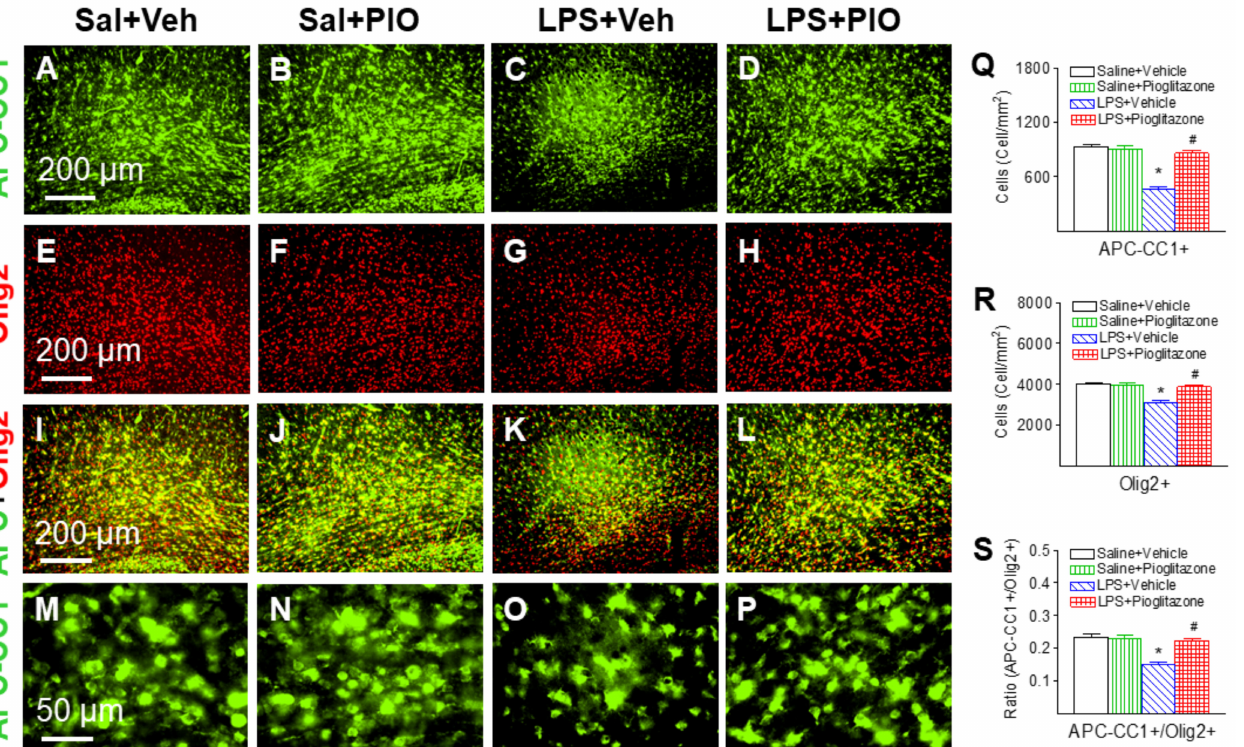
Figure 5. Pioglitazone attenuated neonatal LPS-induced reduction of mature oligodendrocyte cells (APC-CC1+, green) and total oligodendrocytes (Olig2+, red) in the P6 rat brain. APC-CC1+ oligodendrocytes (Saline+Vehicle group: ( A , I , M ); Saline+Pioglitazone group: ( B , J , N )) and Olig2+ (Saline+Vehicle group: ( E , I ); Saline+Pioglitazone group: ( F , J )) were found in the cingulum white matter of the brain sections at the bregma level in P6 Saline+Vehicle and Saline+Pioglitazone groups. Double-labeling (yellow) showed that APC-CC1-positive cells were Olig2+ cells ( I – L ). ( I – L ) are merged images of ( A – D ) and ( E – H ). LPS injection reduced the number of APC-CC1+ cells ( C , K , O ) and Olig2+ cells ( G , K ). Pioglitazone attenuated LPS-induced loss of APC-CC1+ cells ( D , L , P ) and Olig2+ cells ( H , L ). Mature oligodendrocyte cells and total oligodendrocytes were quantified by counting the number of APC-CC1+ cells ( Q ) and Olig2+ cells ( R ) in the cingulum white matter of the brain. The ratio of mature oligodendrocytes (APC-CC1+) to total oligodendrocytes (Olig2+) in each group were shown in ( S ). The results are expressed as the mean ± SEM of eight animals in each group, and analyzed by two-way ANOVA, followed by the Student–Newman–Keuls test. * p < 0.05 represents a significant difference for the LPS + Vehicle group as compared with the Saline + Vehicle group. # p < 0.05 represents a significant difference for the LPS + Pioglitazone group as compared with the LPS + Vehicle